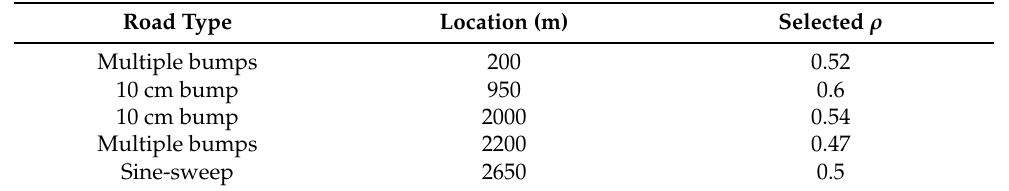
Table 3. Selected scheduling variable.